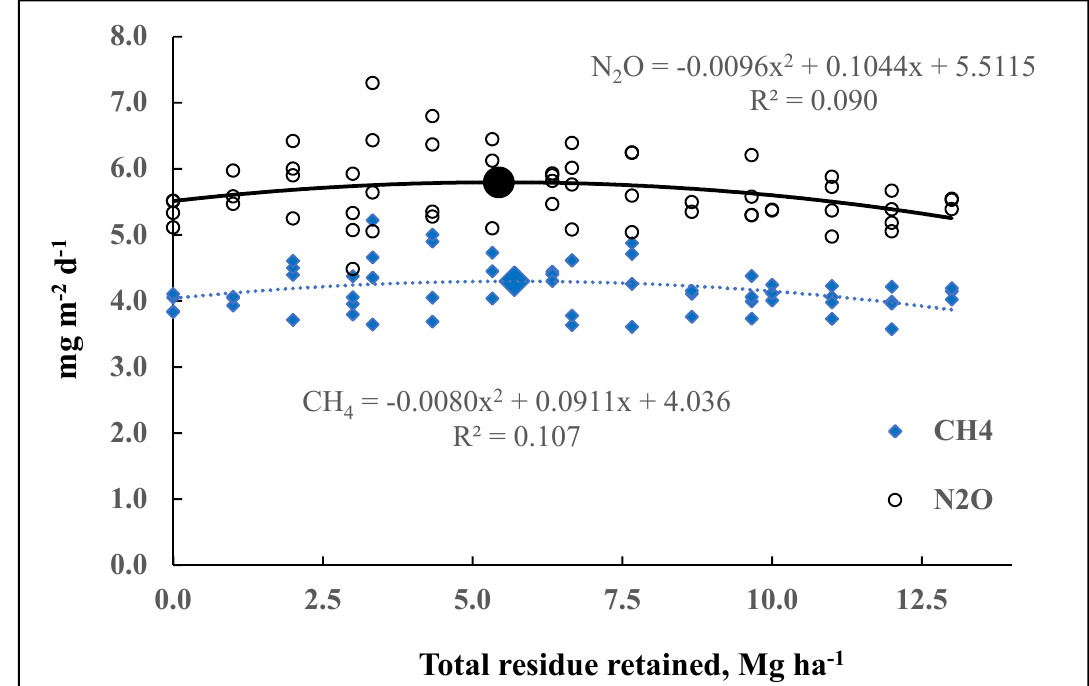
Figure 5. Flux of CH 4 and N 2 O in a factorial design of sixteen total residue retained rates from corn and wheat following a V4 corn nitrogen fertilization in a corn-wheat/soybean rotation in 2017 in New Kent, experiment 2 (NK2), Virginia. Predictor variable total residue retained refers to the sum of corn stover and wheat straw residue treatments allocated in 2015 and 2016. Polynomial best fit line, quadratic equation and coefficient of determination (R 2 ) are presented for each gas. Maximum points ( x’ = − b/2a) and their associated gas response fluxes for each significant quadratic model were calculated and are symbolized by an oversized solid shape (circle, N 2 O = [( − 0.0096 × 5.44 2 ) + (0.1044 × 5.44) + 5.5115] = 5.79 mg m − 2 day − 1 ); diamond, CH 4 = [( − 0.0080 × 5.69 2 ) + (0.0911 × 5.69) + 4.036] = 4.30 mg m − 2 day − 1